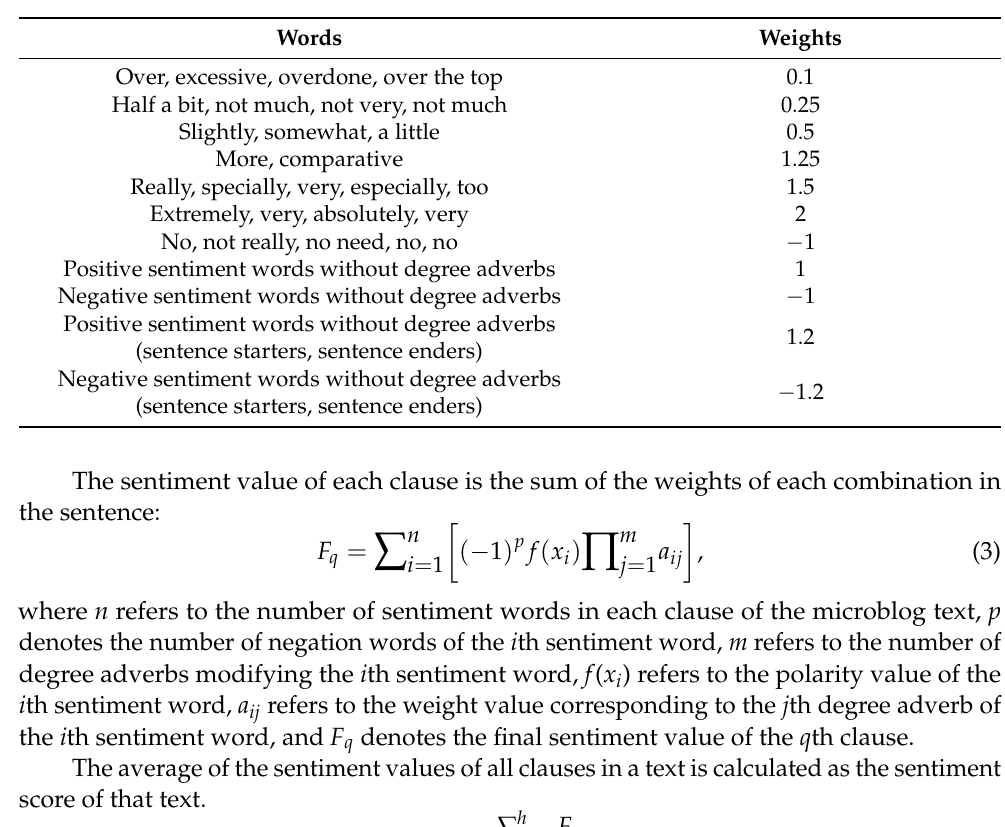
Figure 7. Flowchart of calculating emotion value of word combination.